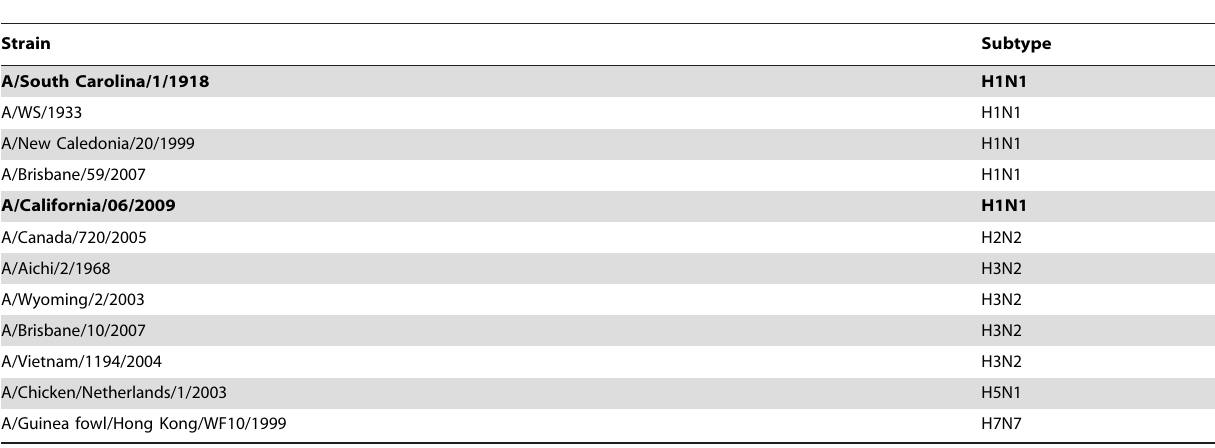
Table 1. Overview of HA1 antigens included in the protein